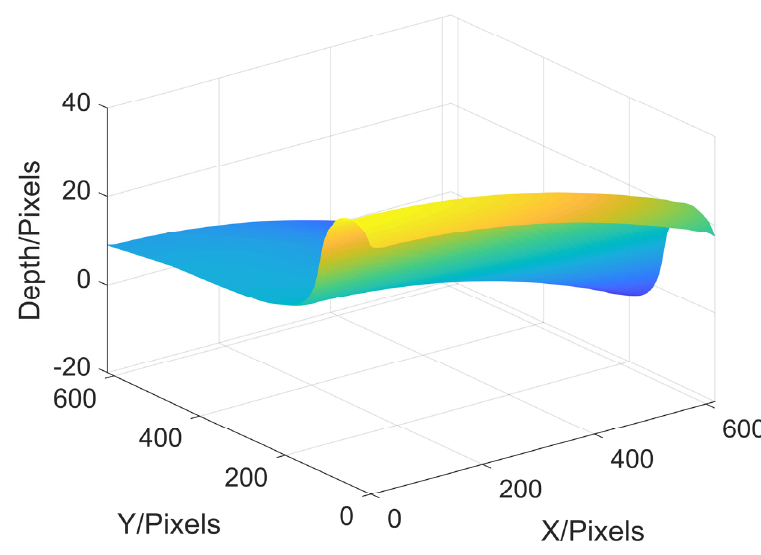
Figure 11. Reconstruction results of wheel tread simulation.